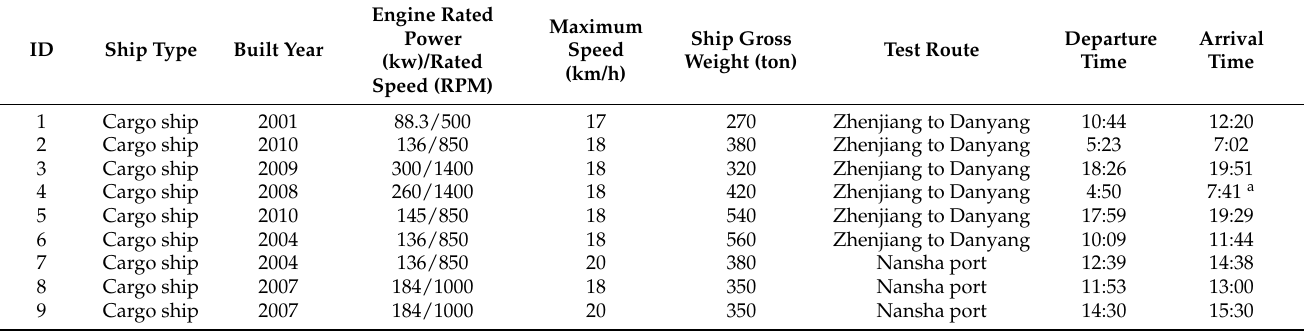
Table 3. Basic information of the test ships.